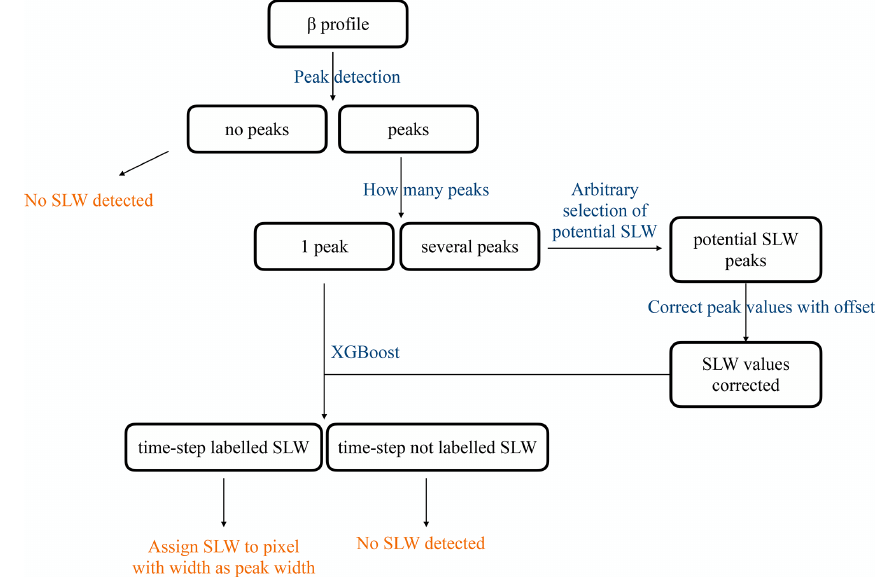
Figure 4. The second phase of G22-Davis: SLW detection as part of the cloud phase mask algorithm.